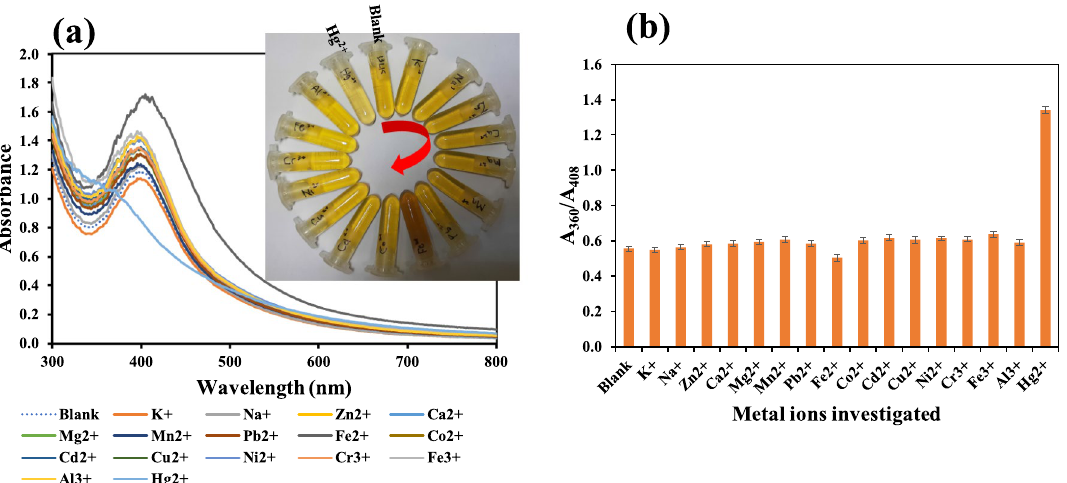
Figure 9. ( a ) UV–vis absorption spectra of KgM-AgNPs under charging with different metal ions, from blank-Hg 2+ ( b ) Plot of A 360 /A 408 vs various metal ions of environmental significance, Hg 2+ concentration was at 30.0 µM, while other metal ions were fixed 150.0 µM.